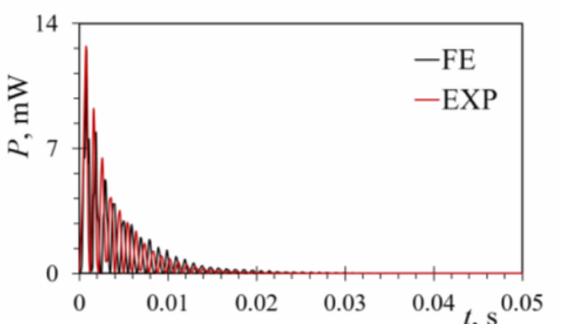
Figure 18. Experimental and transient FE FUC power outputs for a rectangular bimorph PEH excited by plucking its free